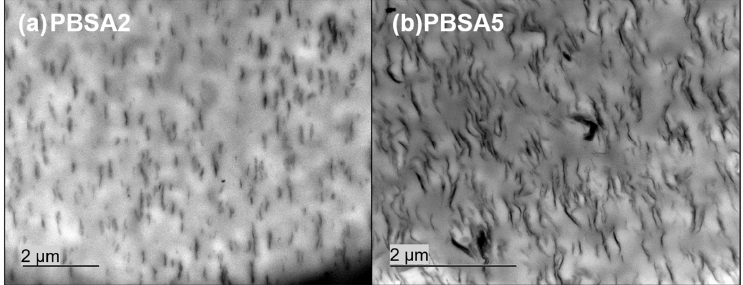
Figure 1. TEM observations for PBSA filled with ( a ) 2% and ( b ) 5 wt% of montmorillonite